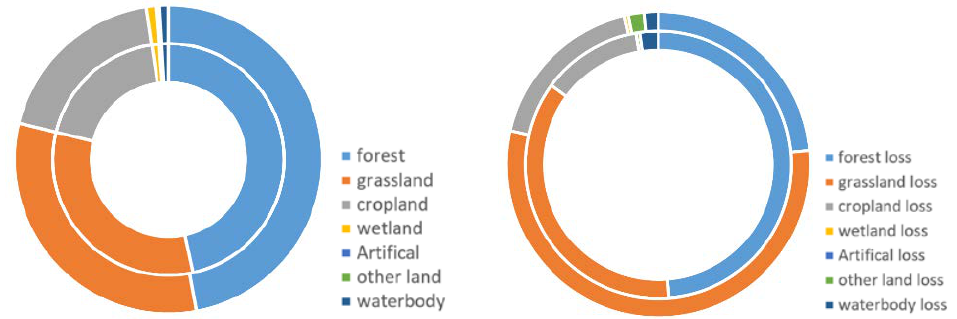
Figure 5. Land cover change and loss from 1992 to 2018 in Great Khingan Mountain (GKM), China (inner circle: 1992–2000; outer circle: 2000–2018).